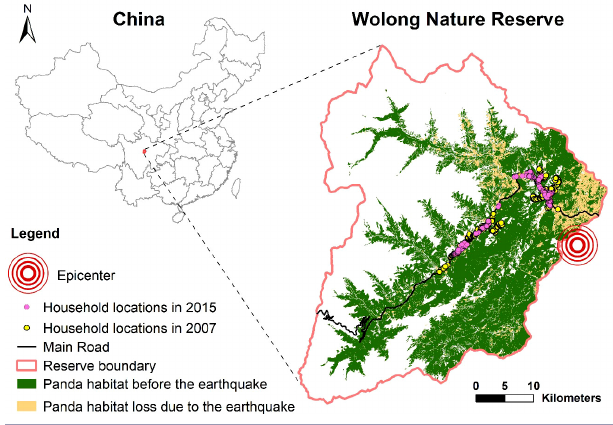
Fig. 2 . Map of Wolong Nature Reserve, Sichuan, China. Depicted are the location of epicenter of the 2008 Wenchuan earthquake and the distribution of local households before and after the earthquake. Brown portions labeled “habitat loss” represent areas identified in (Ouyang et al. 2008) as forest loss due to the